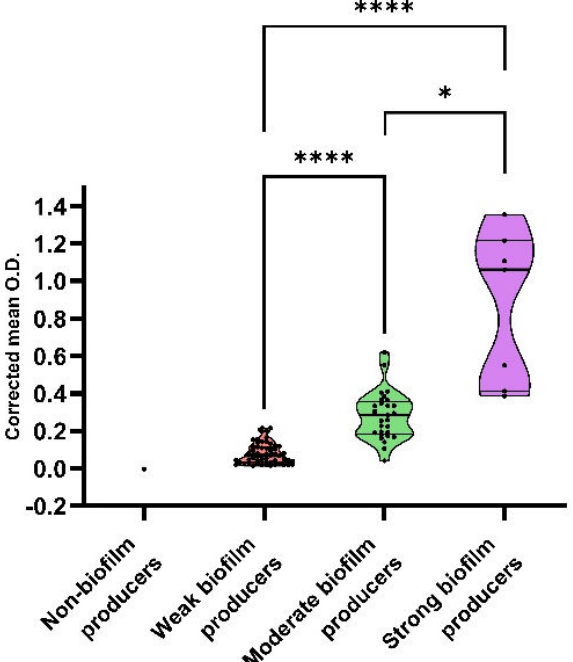
Figure 1. Corrected mean optical density (O.D.) values of the different biofilm classes. Lines within violin plots represent median, 25th, and 75th percentile. p < 0.05 is shown as * and p < 0.0001 as ****. 2.2. Distribution of Biofilm-Producing ESBL/pAmpC E. coli along the Poultry Production Pyramid The frequency of biofilm classes among sampling sites (i.e., production chains and stages of the production pyramid) is listed in Table